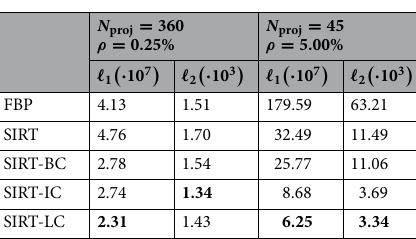
Figure 9. An example of the residual of the five different algorithms for the best (upper row) and worst (lower row) data cases. Slice 171/256 at time step 51/100 is shown in the figure. Pixel values are constrained to be within ± 0.1 in the upper row and within ± 0.5 in the lower row.